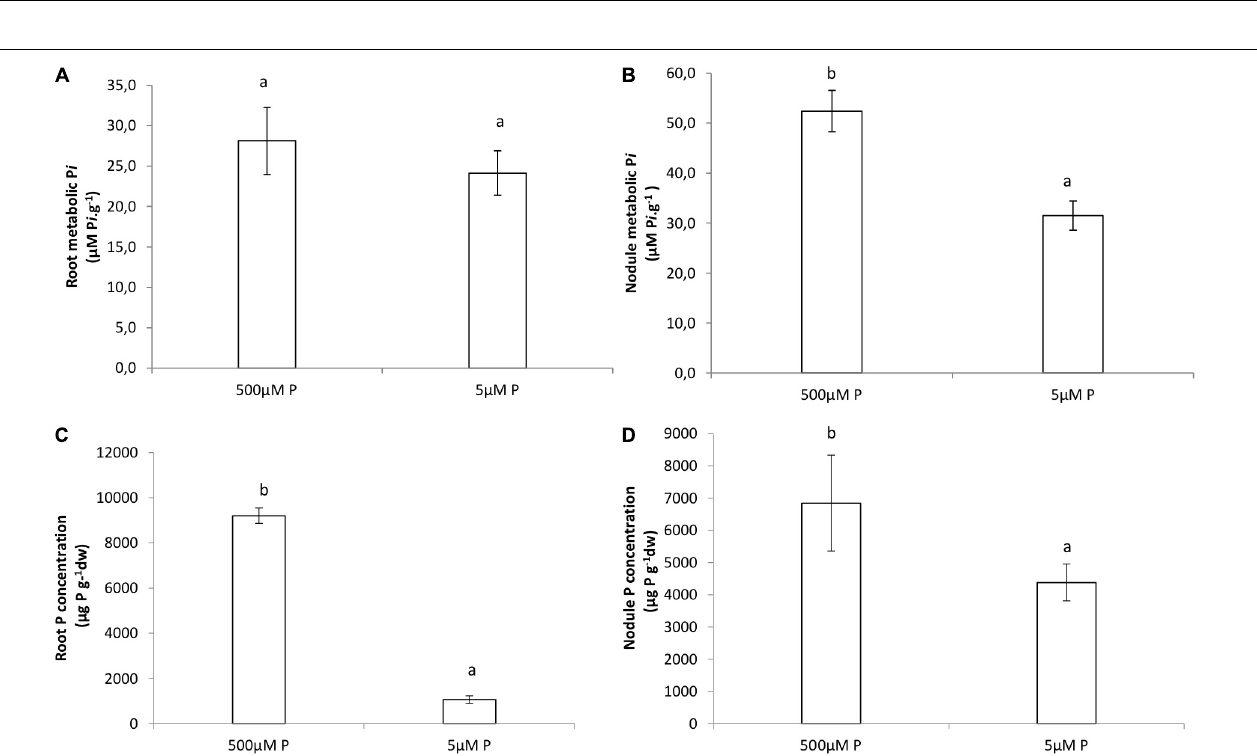
FIGURE 4 | Organic acids concentrations (mg.mol.g − 1 FW) by GCMS analysis in roots and nodules of V. divaricata , grown under high phosphate (500 µ M P) and low phosphate (5 µ M P) conditions. Citric acid concentration in (A) roots, (B) nodules. Malic acid concentration in (C) roots (D) , nodules. Values of four replicates are presented as means ± SE. Different letters indicate significant differences between treatments ( P ≤ 0.05).